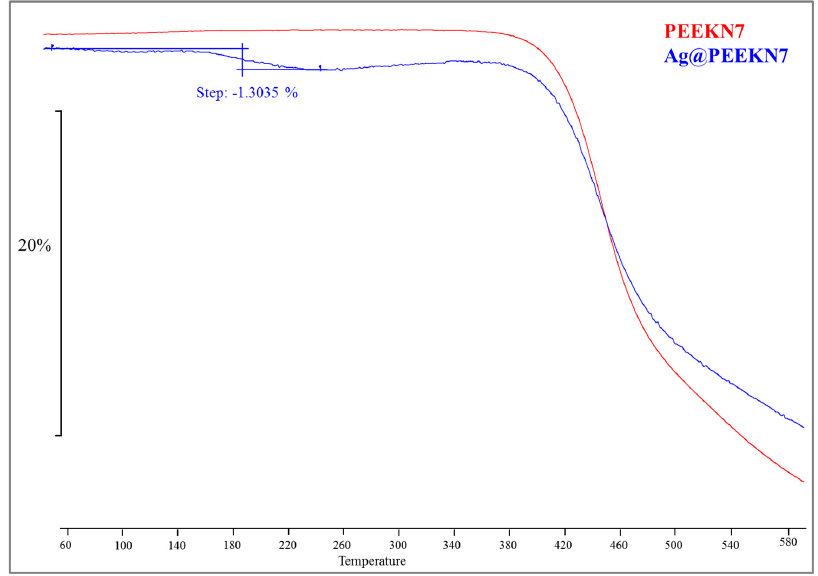
Figure 12. Thermogravimetry analysis of the precipitate of silver nitrate with PEEKN7